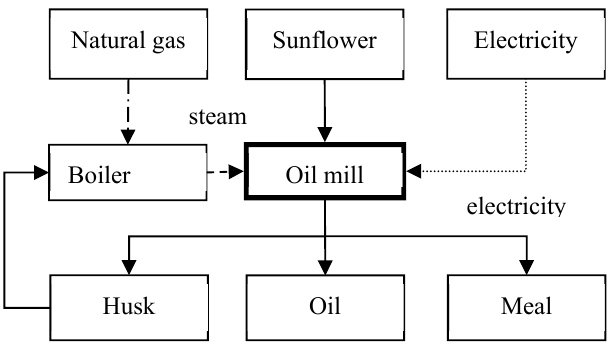
Figure 2. Basic scheme of a Sunflower Seed Oil Mill.